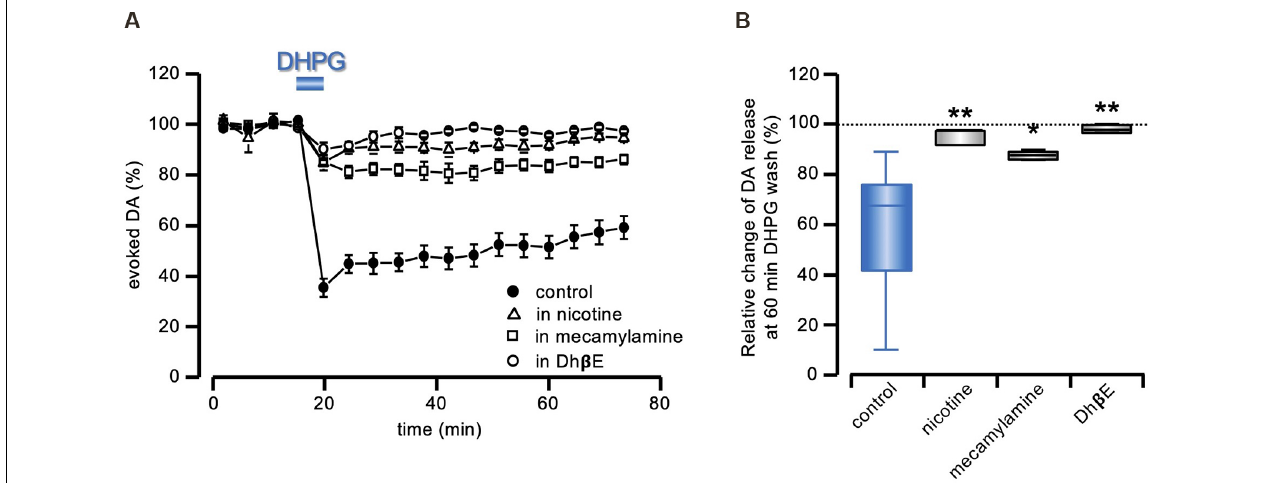
FIGURE 3 | DA-LTD prevented by nAChRs stimulation or inhibition. (A) Running plots of the mean relative amplitude ( ± s.e.m.) of evoked DA release, obtained with amperometric recordings at 5 min stimulation interval, in response to a 5 min exposure to DHPG (50 µ M), in control conditions, or in the continuous presence of 100 nM nicotine ( n = 5 slices from three animals), 500 nM mecamylamine ( n = 4 slices from two animals) or 1 µ M Dh β E ( n = 4 slices from two animals). The control plot is the same as illustrated in Figure 1 . (B) Box and whiskers plot of the change in evoked DA release, 60 min after DHPG (50 µ M) washout, relative to the DA signal preceding the DHPG treatment, in the presence of the drugs indicated on the abscissa. All statistical comparisons are made against the same control as in Figure 2B (blue box), i.e., DHPG treatment with no additional drug (* P < 0.05; ** P < 0.01, 1-way ANOVA followed by Bonferroni’s